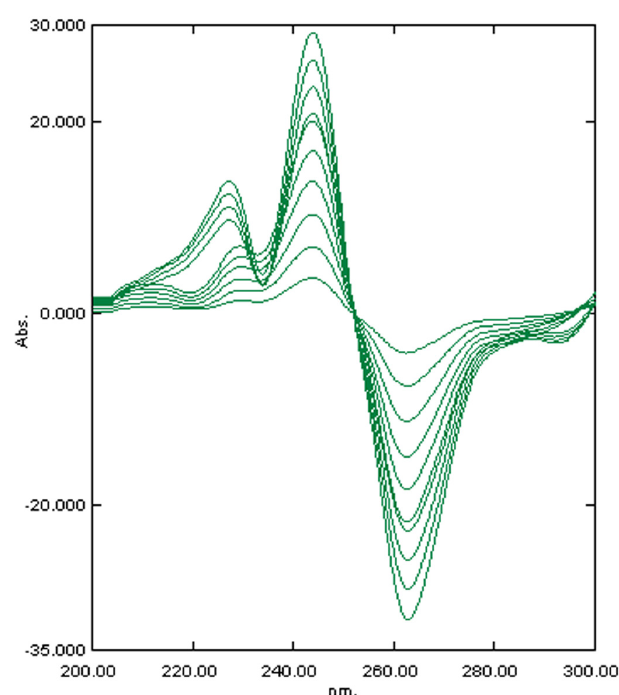
FIGURE 5 – Ratio Derivative spectra of